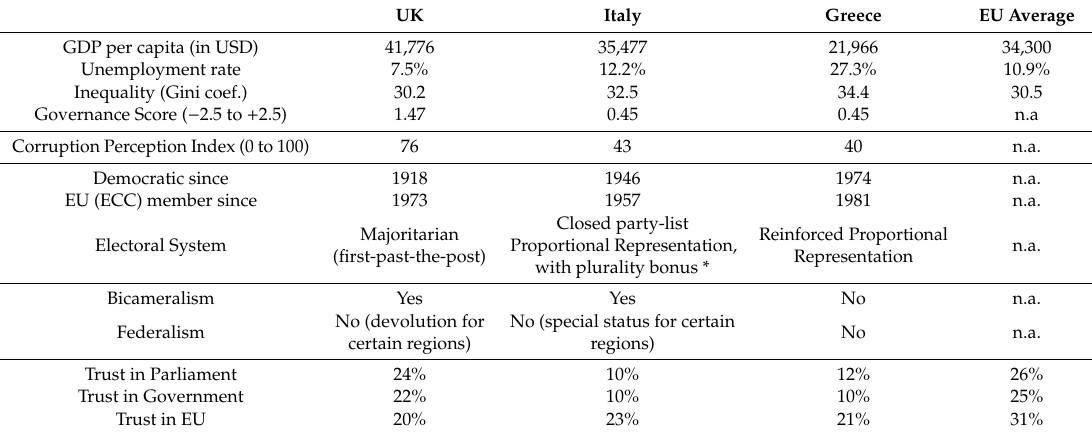
Table 1. Institutional, political and economic information on selected countries